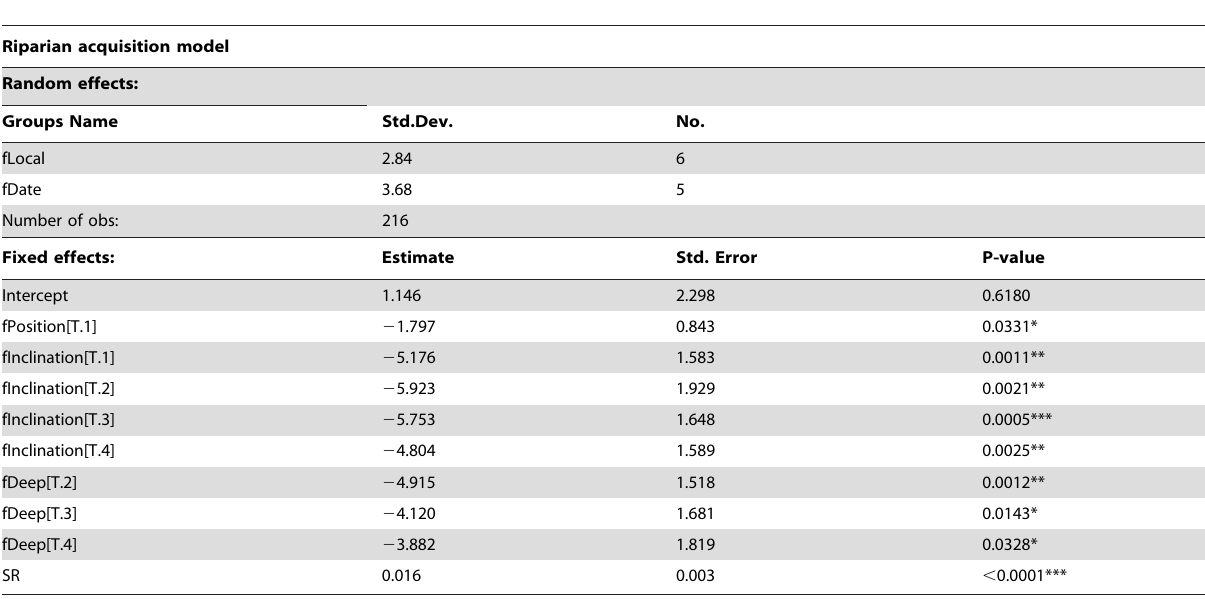
Table 4. Results of the Riparian GLMM model to predict GPS fix-success